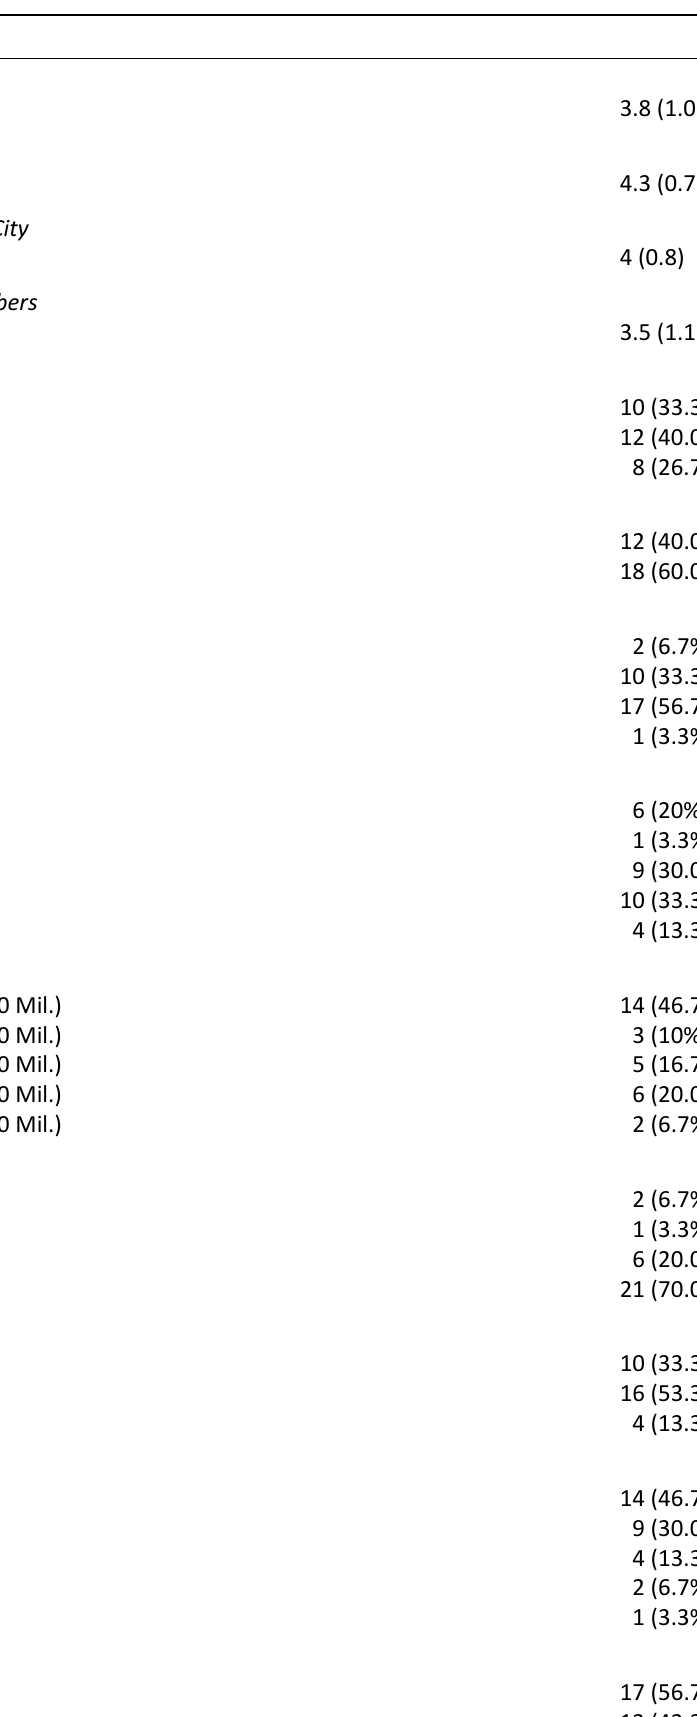
Table 2. Descriptive